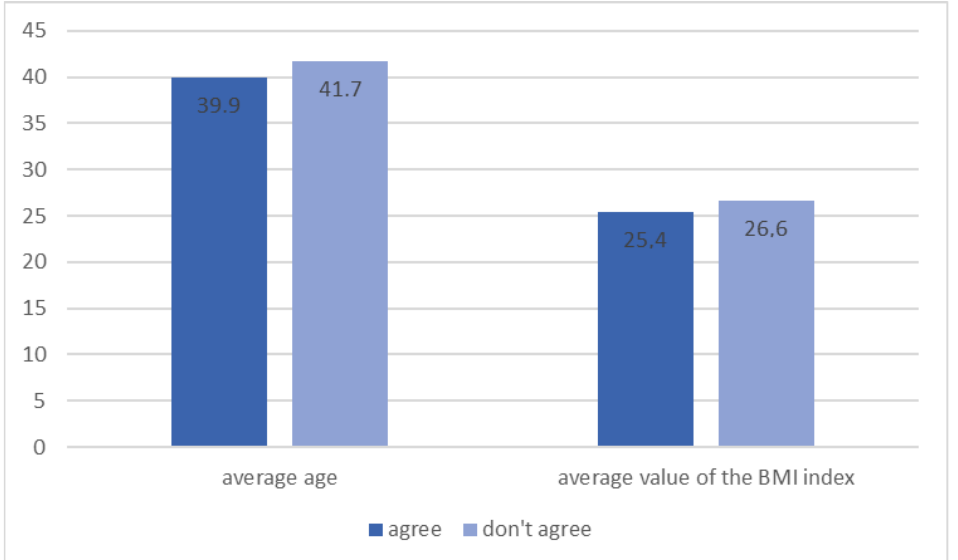
Figure 5. Patients’ opinion on the role of regular physical activity in preventing the development of diabetes depending on average age and BMI level ( n = 131, p = 0.005).